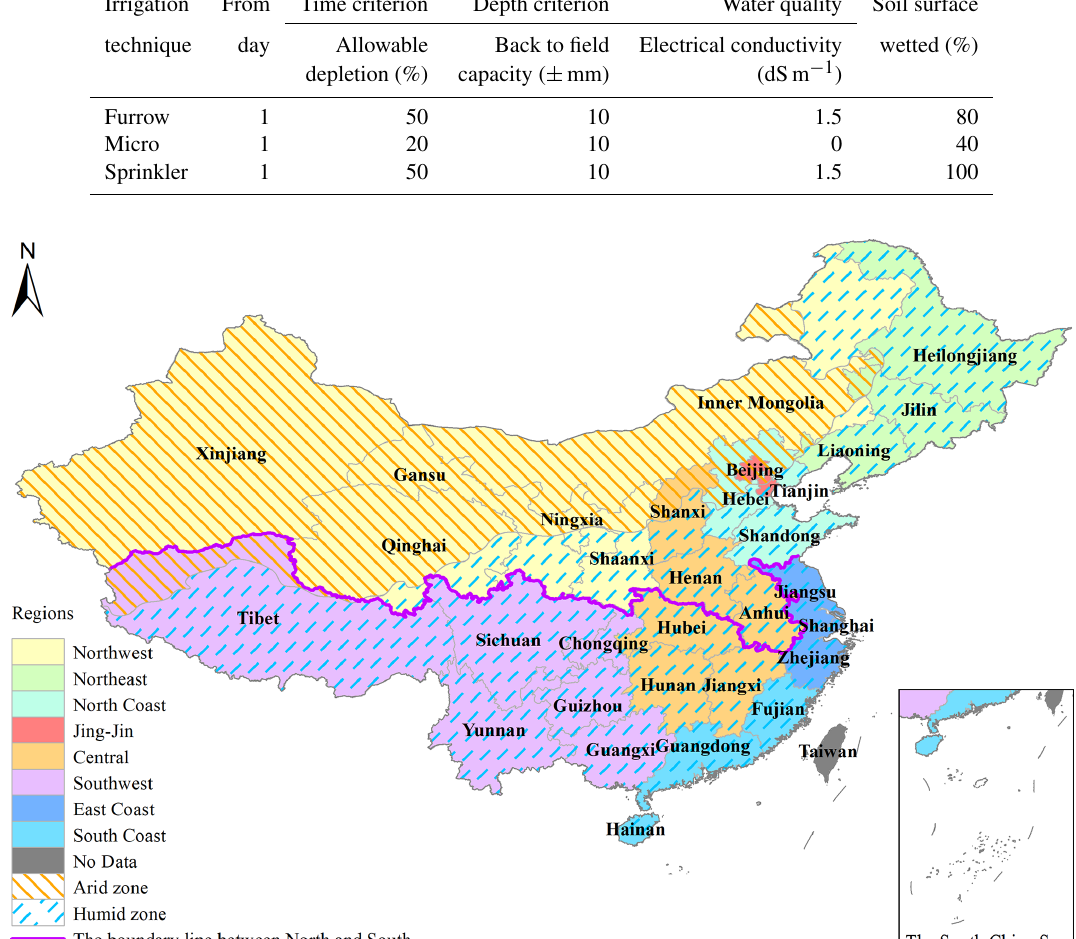
Figure 2. Regions and climate zones of mainland